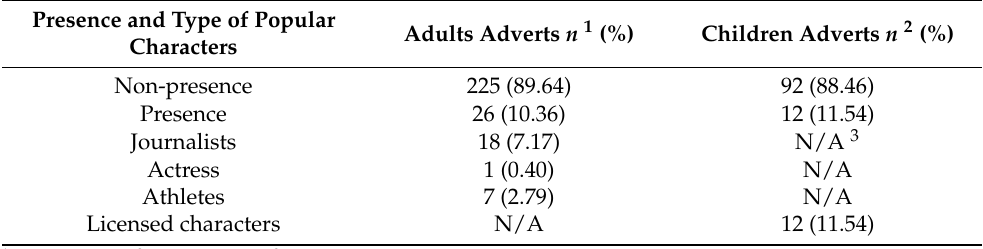
Table 3. Presence of popular characters in the analyzed